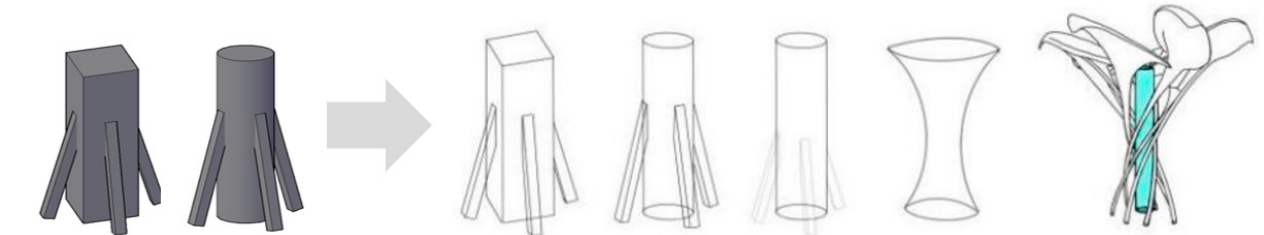
Figure 19. The product shape modification and transformation process.